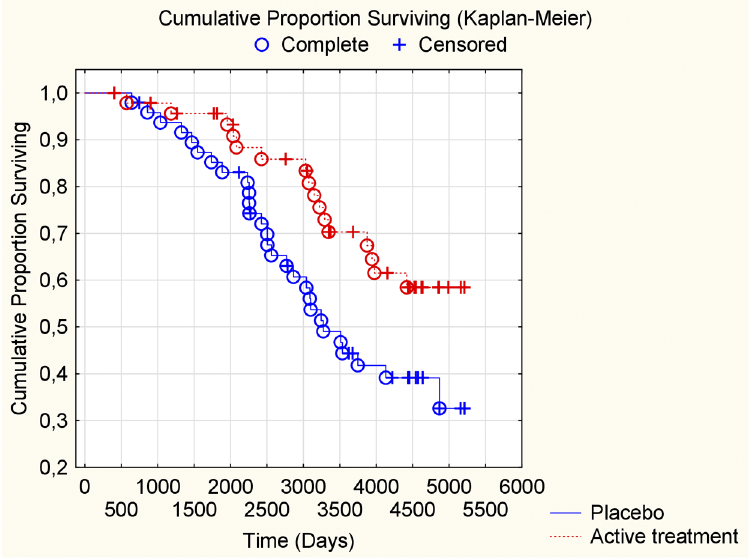
Fig 3. Kaplan-Meier graph illustrating cardiovascular mortality in participants with ischemic heart disease during a follow-up period of 12 years of those supplemented with selenium and coenzyme Q10 versus placebo for four years on top of regular pharmaceutical treatment.